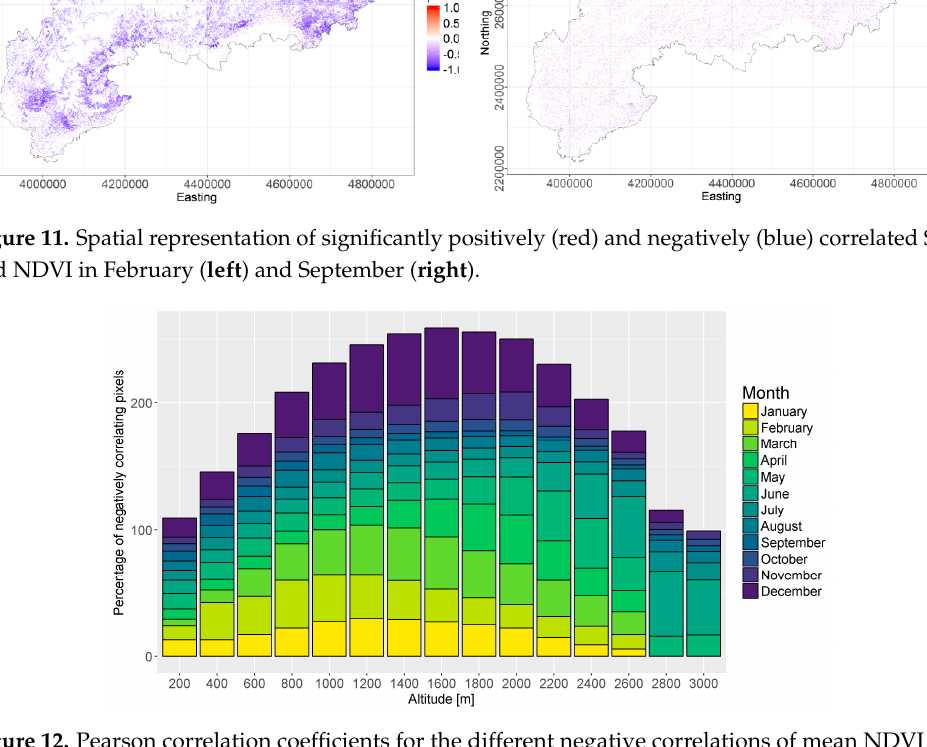
Figure 12. Pearson correlation coefficients for the different negative correlations of mean NDVI and SCD of the respective same month over different altitude ranges.